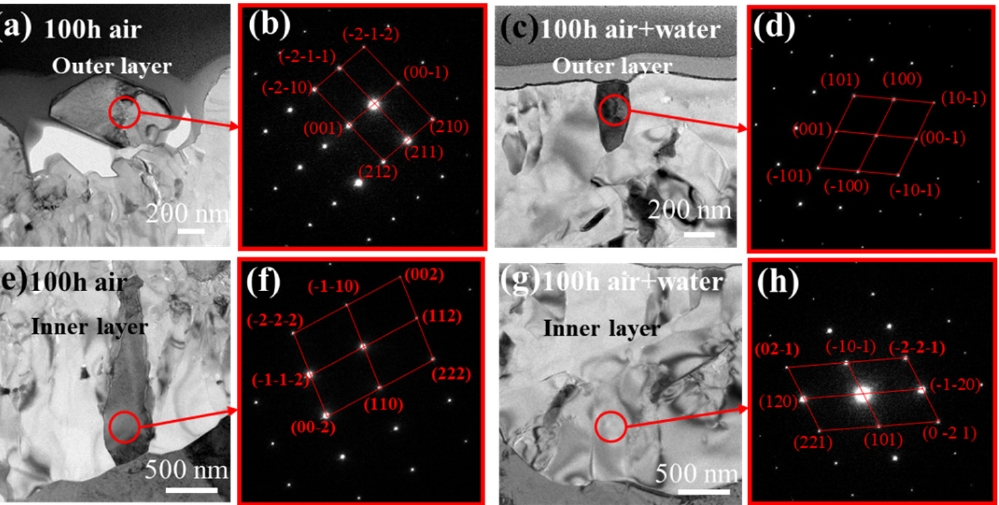
Figure 12. TEM image of alumina particle morphology and its diffraction spots after oxidation at 1100 °C for 100 h: air, in the outer layer ( a , b ); air–water vapor, in the outer layer ( c , d ); air, in the inner layer (e, f); air–water vapor, in the inner layer ( g , h ).